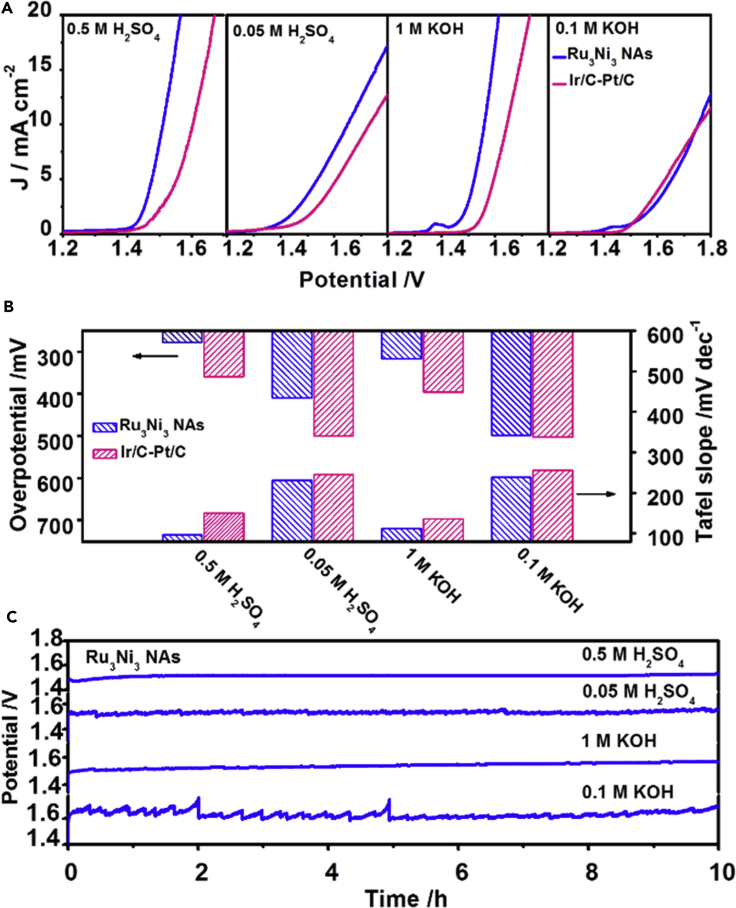
Overall Water Splitting Performances of the Ru-Ni NAs under Different pH Conditions(A and B) (A) Polarization curves for the overall water splitting and (B) the overpotentials and Tafel plots of the Ru3Ni3 NAs and Ir/C-Pt/C in 0.5 M H2SO4, 0.05 M H2SO4, 1 M KOH, and 0.1 M KOH.(C) Chronopotentiometry curves of the Ru3Ni3 NAs in 0.5 M H2SO4, 0.05 M H2SO4, 1 M KOH, and 0.1 M KOH at a constant current density of 5 mA cm−2.